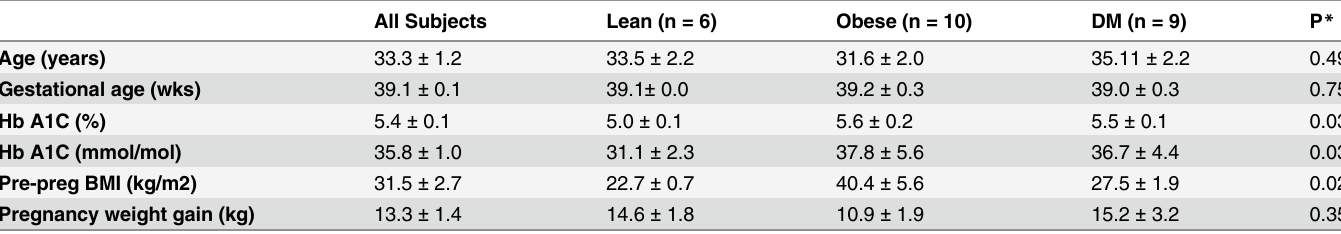
Table 1. Subject characteristics.